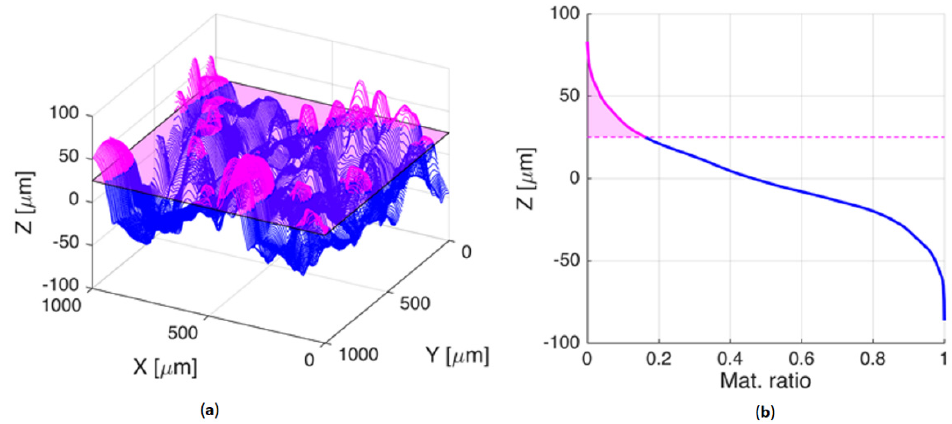
Figure 4. Procedure for evaluating material ratio curve in 3D: ( a ) the XY plane and ( b ) the resulting curve.